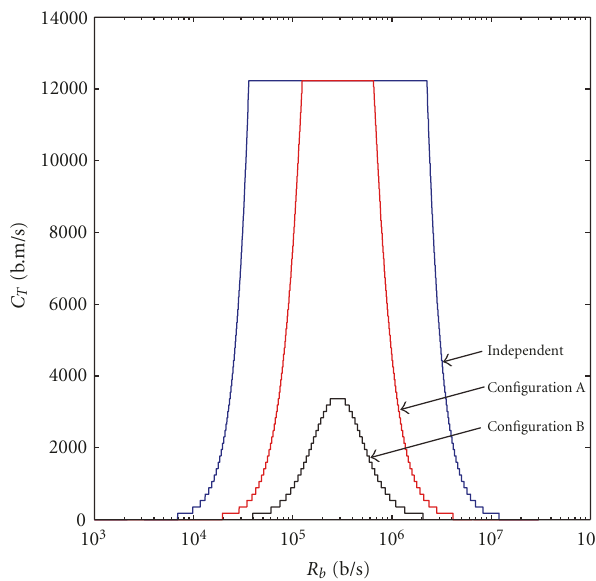
Figure 8: C T versus R b for 16 QAM modulation with three Nakagami- m fading channels using 2D node distribution ( m = 1, K =